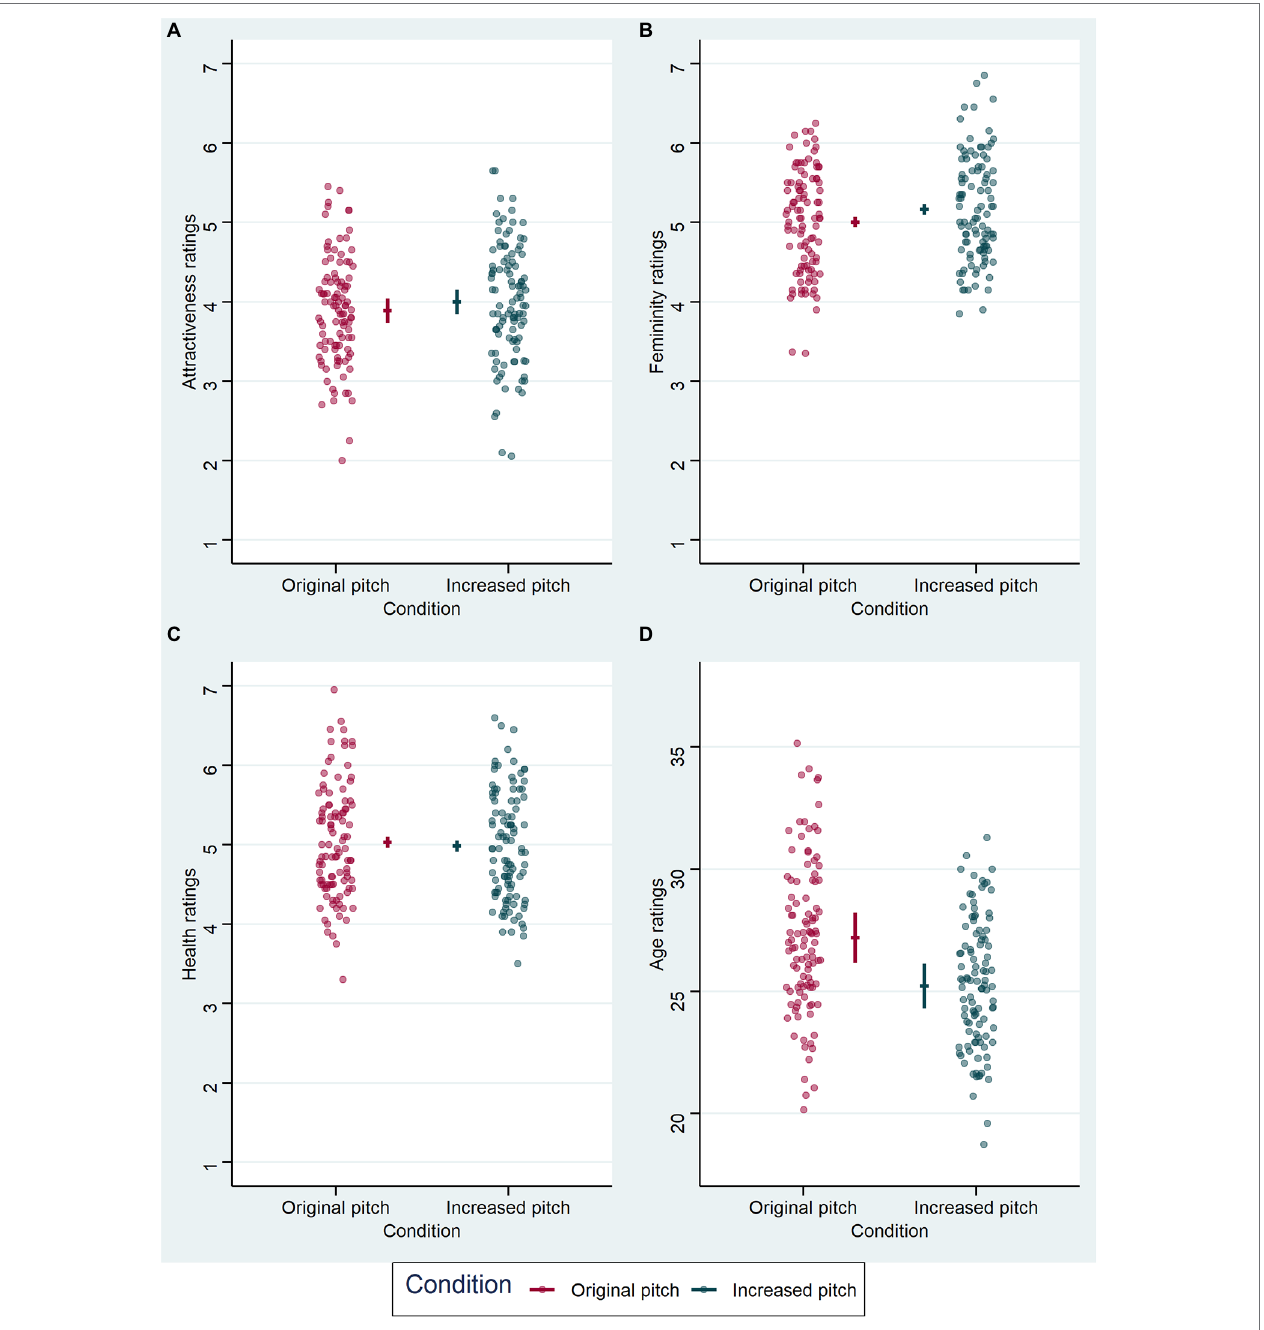
FIGURE 4 | Results from the LMM analyses of voice ratings in the audio block. Each graph represents the effect of voice pitch on the respective voice judgment: (A) for attractiveness ratings, (B) for femininity ratings, (C) for health ratings, and (D) for age ratings (in years). Condition is indicated on the x-axis and color-coded, original voice pitch in dark pink and increased voice pitch in dark cyan. Data points (circles) represent mean values per subject and are jittered horizontally for visualization purposes. Horizontal lines show model estimate for each condition and error bars represent 95% confidence intervals of the model